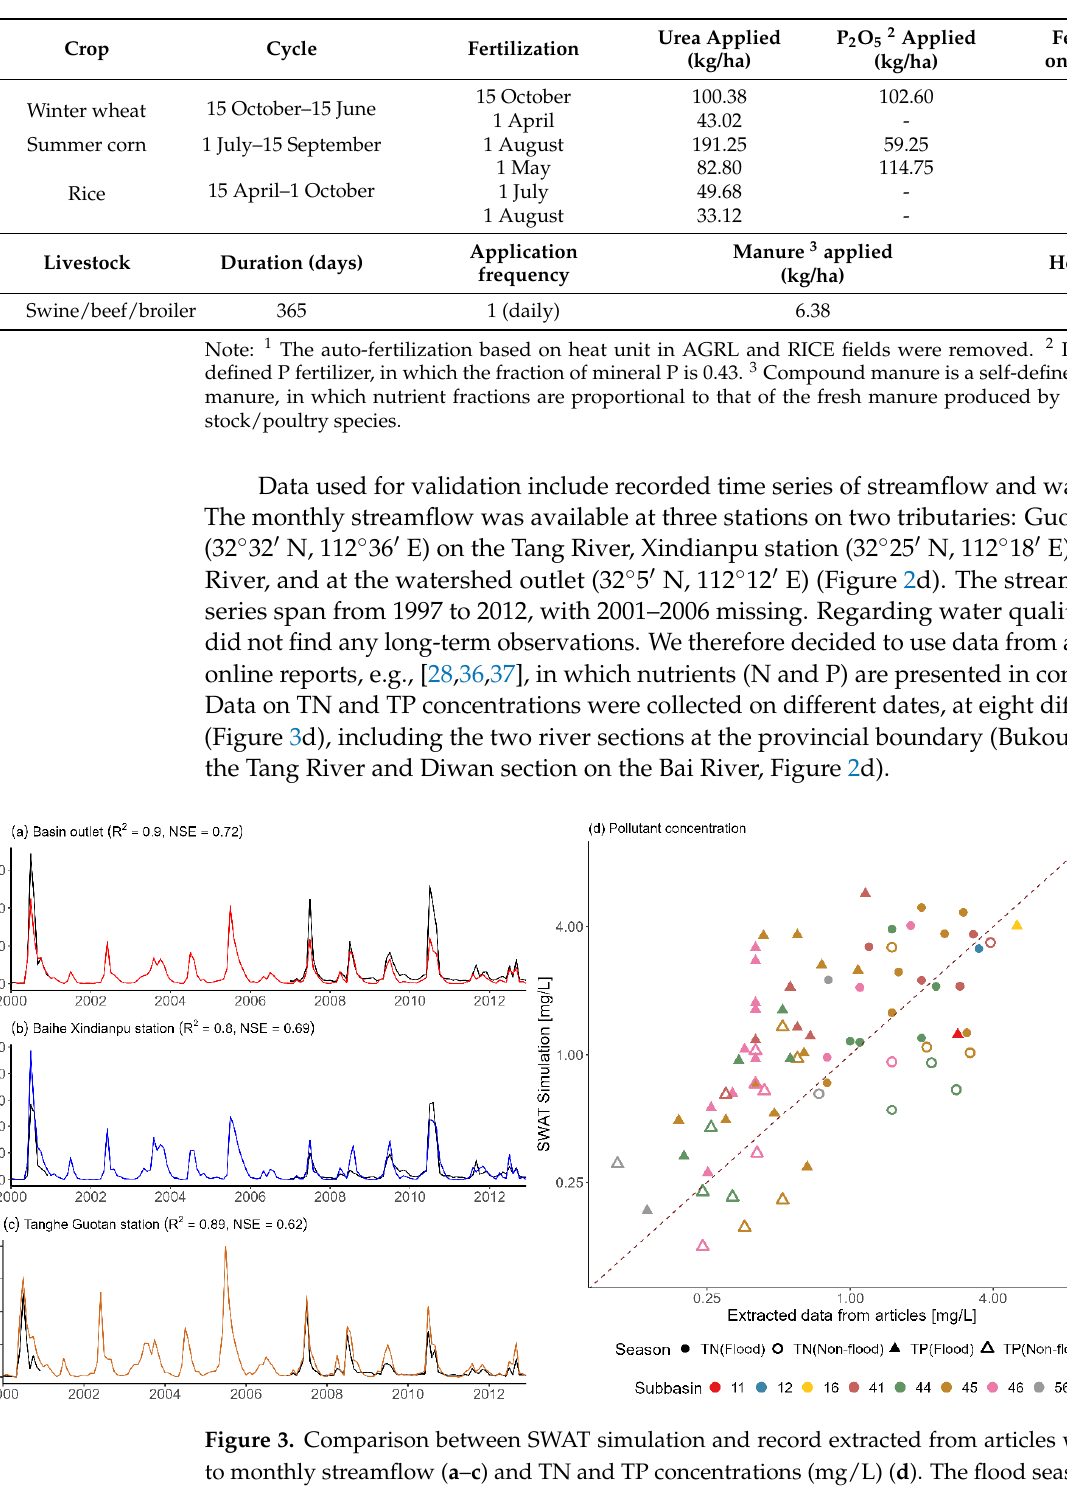
Table 2. Settings on non-point-source pollution from planting in terms of crop cycle and management practices, and livestock breeding in terms of manure discharge in rural areas based on land cover in 2015.